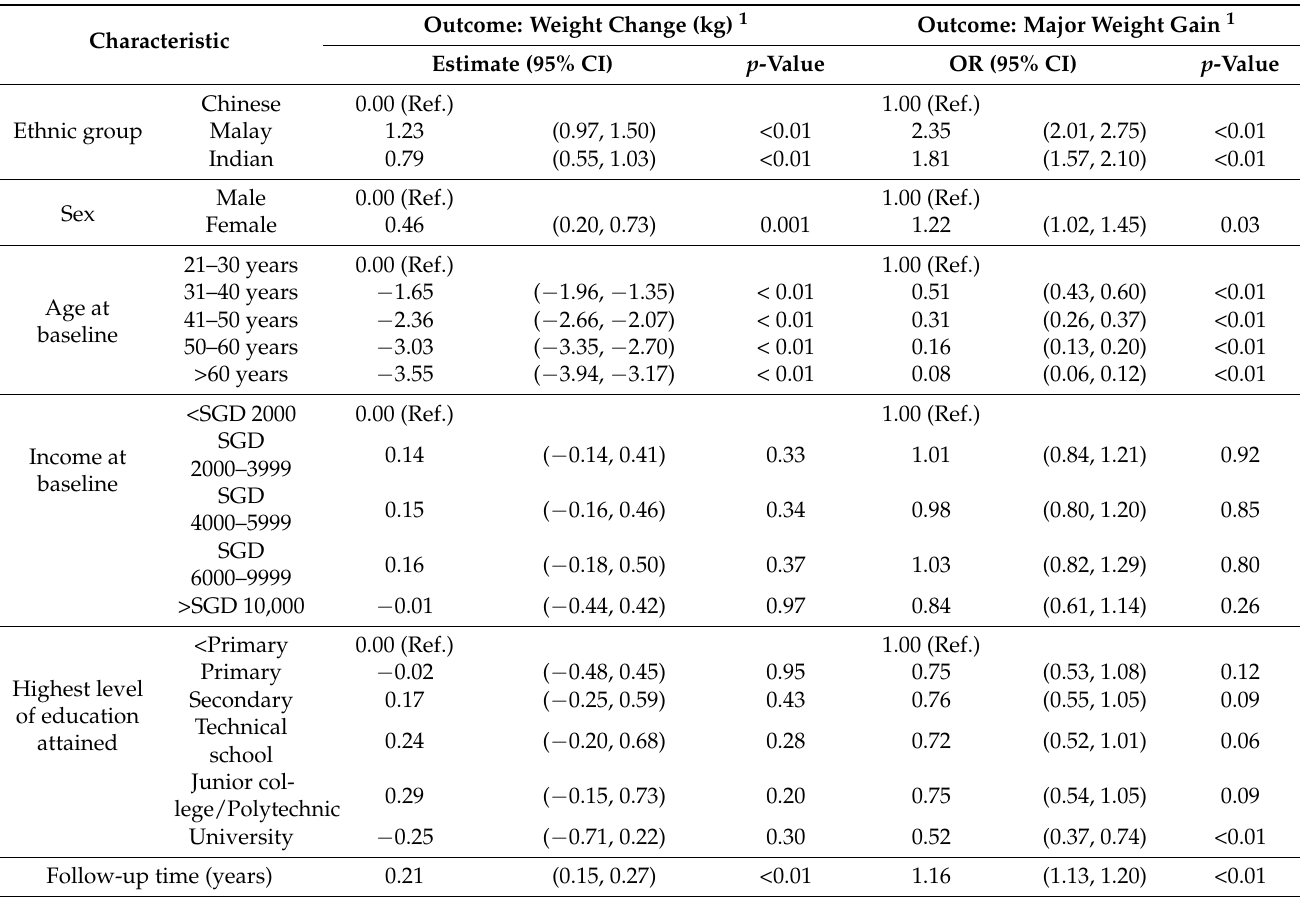
Table 2. The association between socio-demographic characteristics and weight change during follow-up in Singapore Multi-Ethnic Cohort participants aged 21 years and